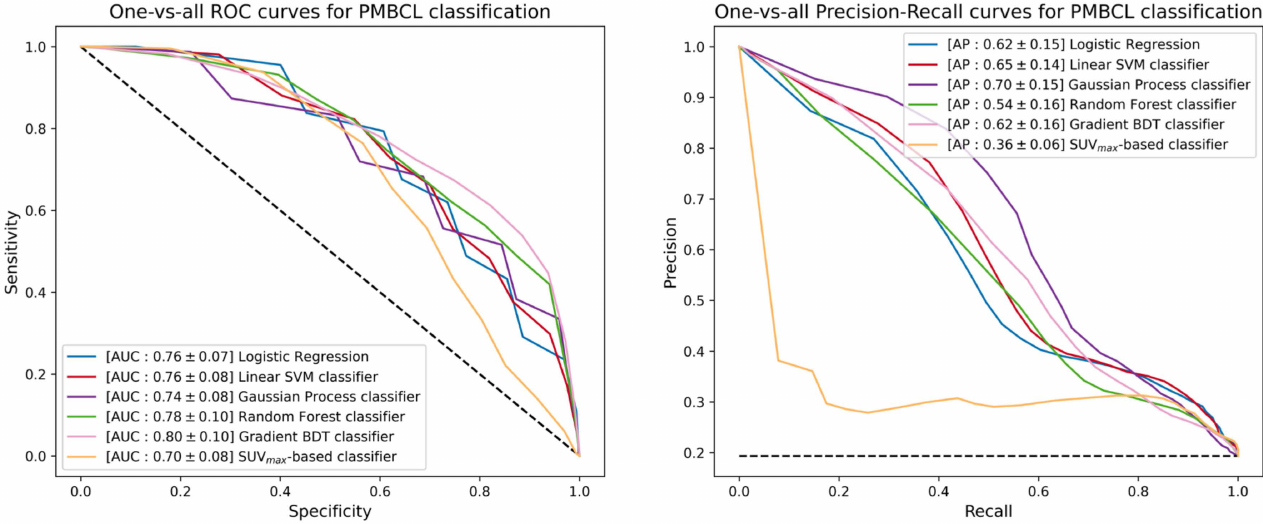
Figure 6. ROC curves ( left ) and precision-recall curves ( right ) of the different multiclass-promoted binary classifiers under investigation. Each classifier is reported together with mean and standard deviation (in square brackets) of the one-vs-all AUC and AP scores achieved during a 300-iterated bootstrap technique for GZL classification.